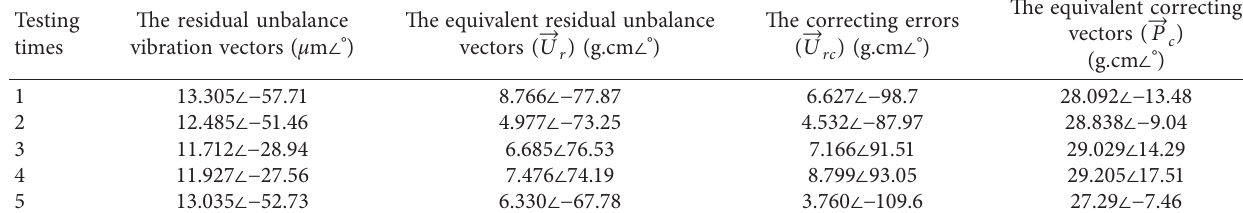
Table 3: The online correcting results for unbalance workpiece.